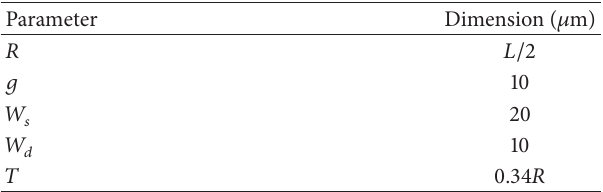
Table 1: Design parameters of the